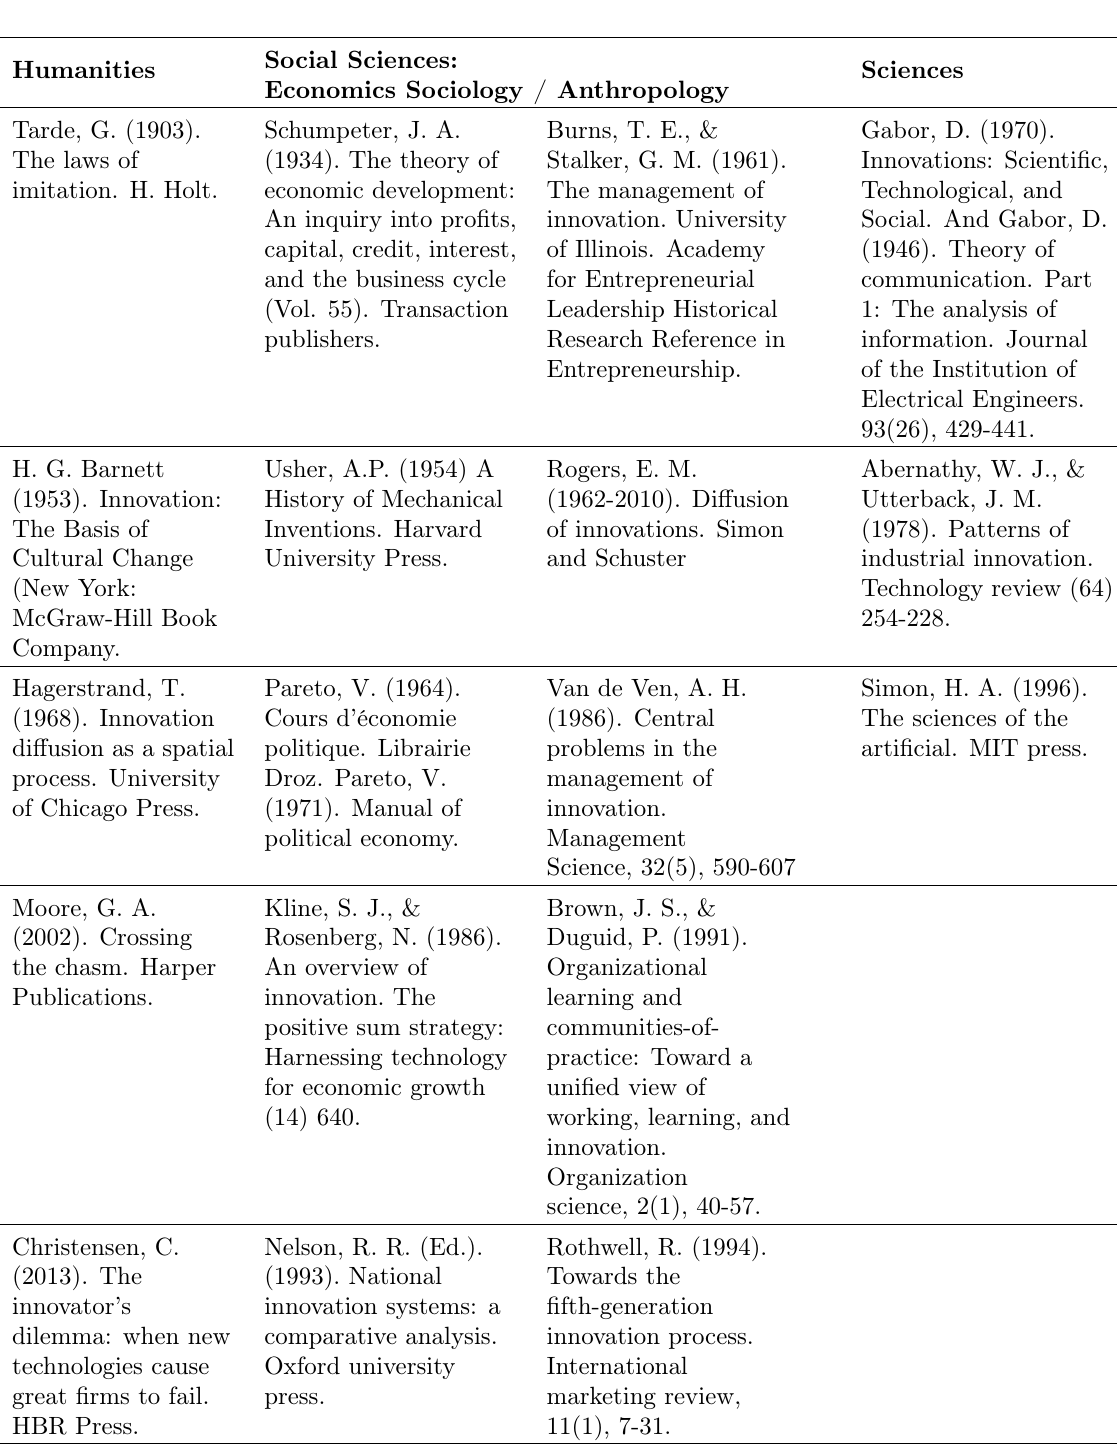
Table 1. Most cited literature on the innovation